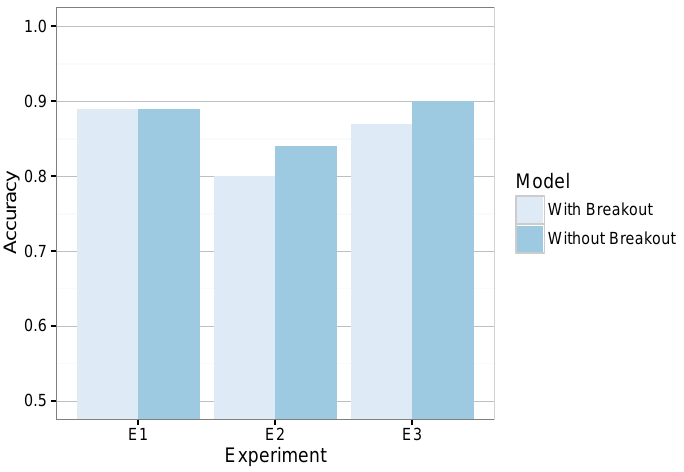
Figure 9. Evaluation error of the system when the speed-based breakout detection is activated or